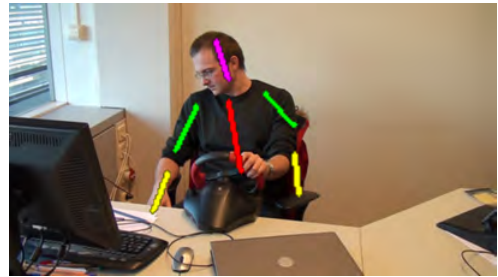
Figure 10. Incorrect detection of left